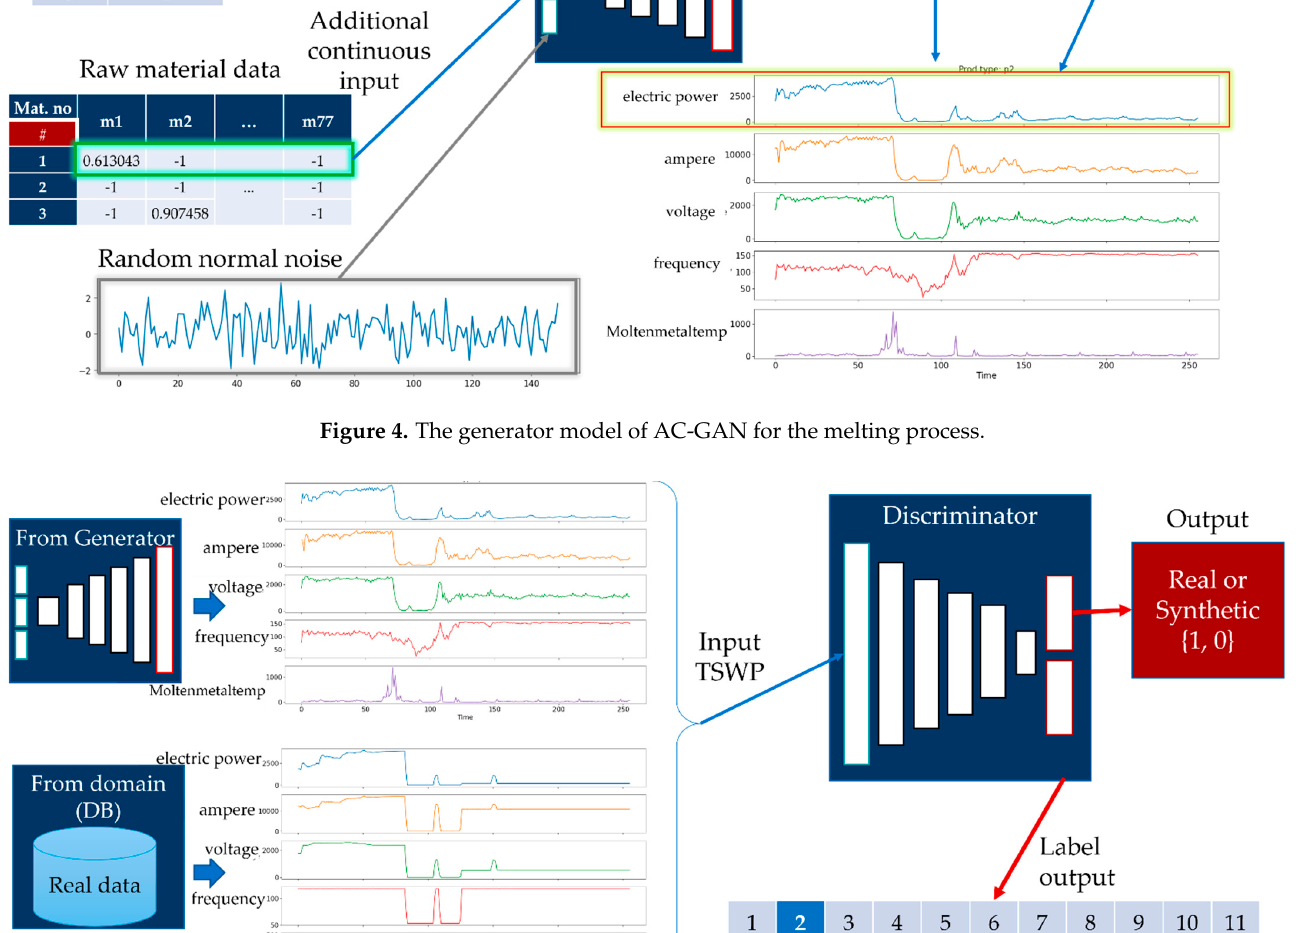
Figure 4. The generator model of AC ‐ GAN for the melting process.